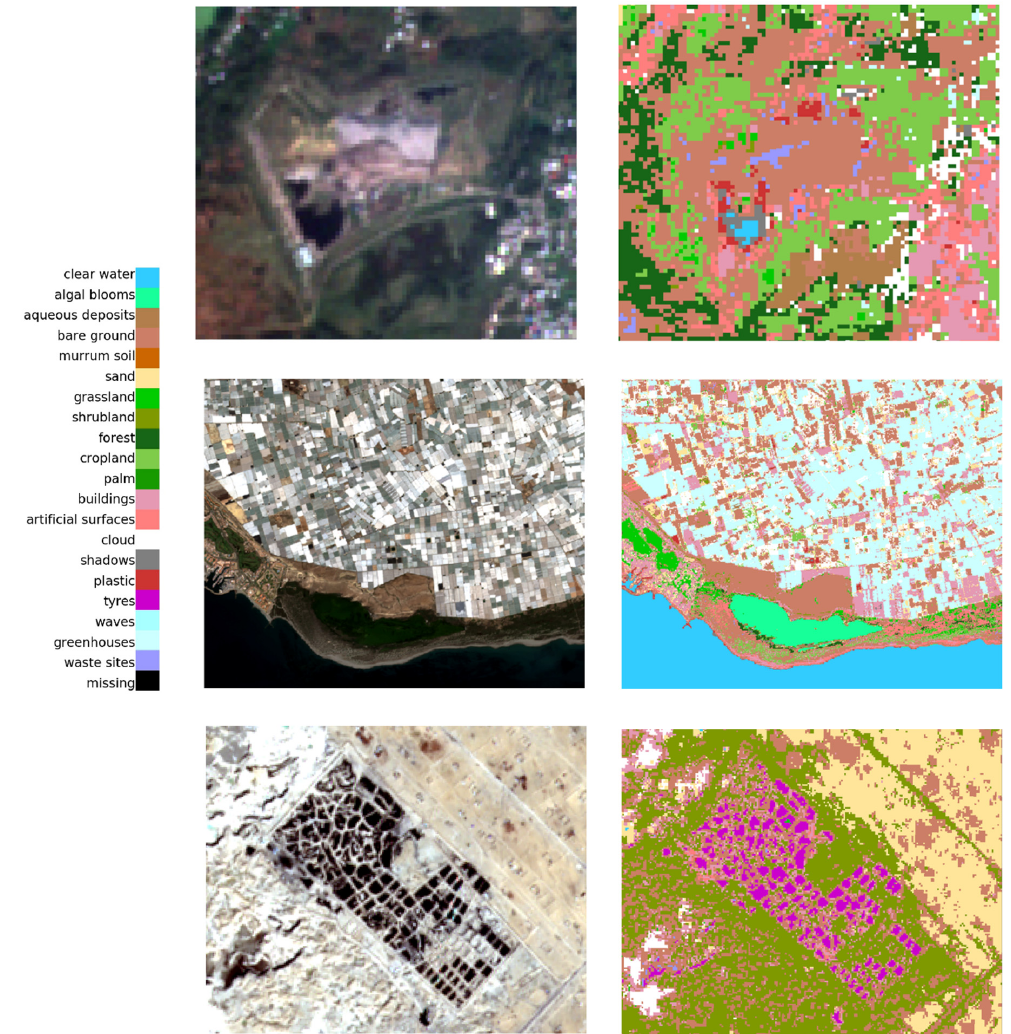
Figure 13. Comparison of the Sentinel-2 pseudo-true colour image (bands B04, B03 and B02 as red, green, and blue) on the left and classification output for the terrestrial locations on the right. From top to bottom, the subset areas are the Srinagar Landfill with plastic (red) and waste (lilac) detected within the boundaries of the site, the tyre graveyard in Kuwait with the tyre piles classified as tyres (cerise), and Almería with greenhouses (light blue) detected alongside plastic (red).